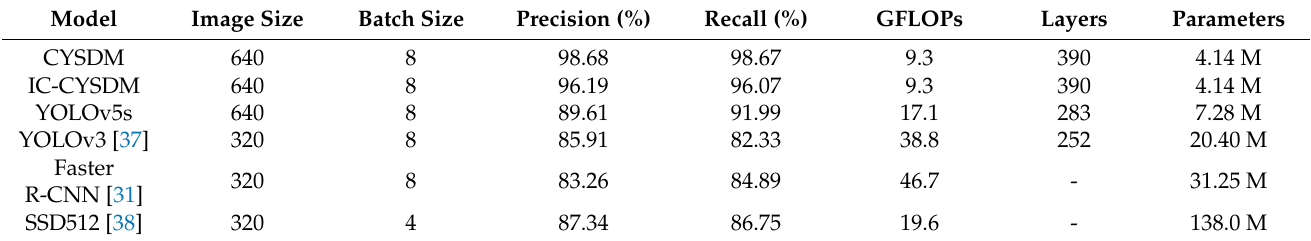
Table 5. Experimental ship detection results for several models.